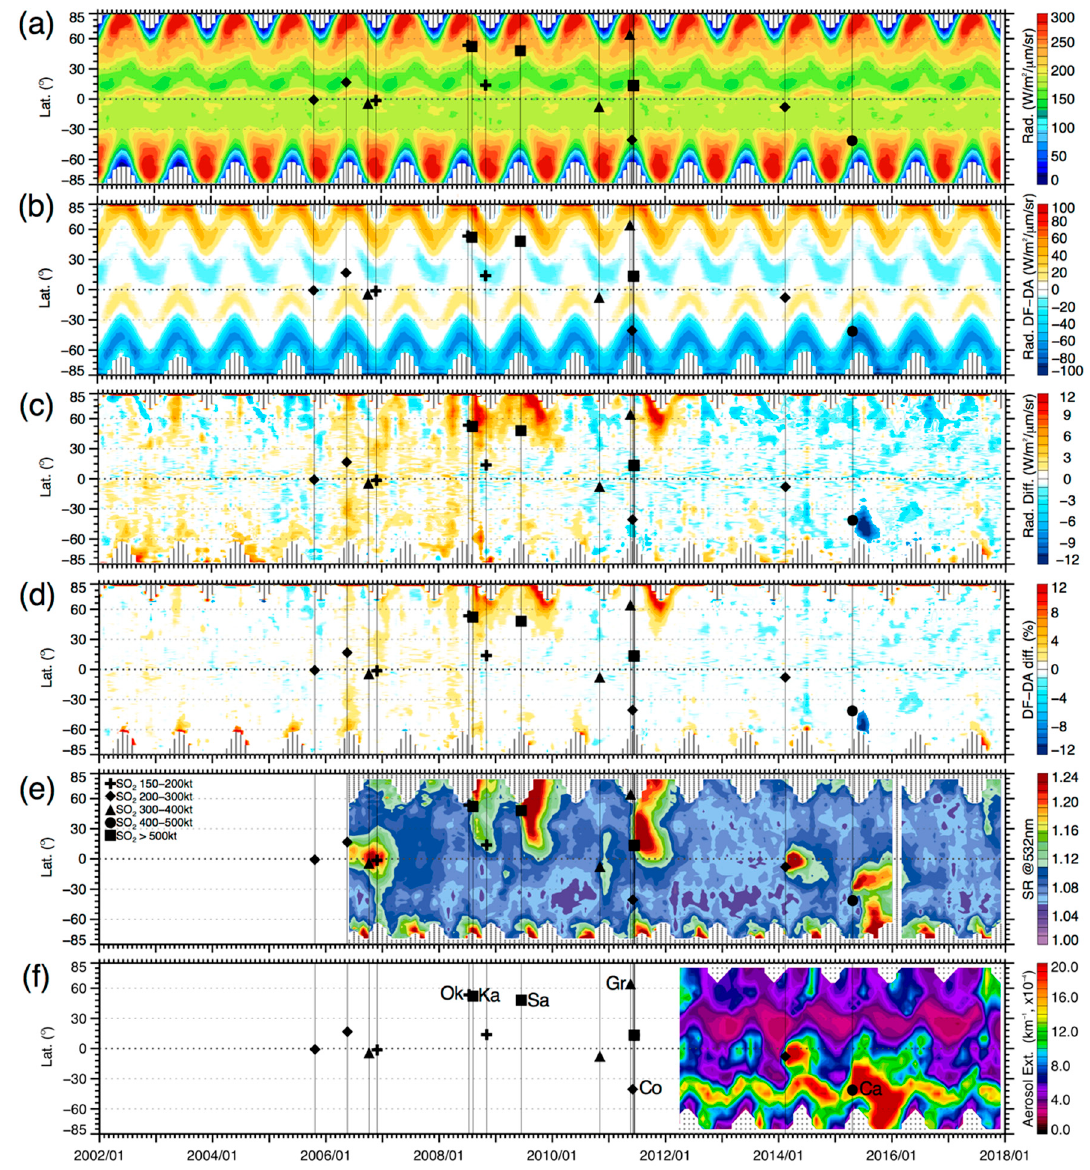
F igure 8. Time series of MISR monthly radiances from the blue band ( a ) DF, ( b ) DF-DA, ( c ) de-seasonalized DF-DA radiance, ( d ) de-seasonalized DF-DA difference in %, ( e ) CALIPSO lidar SR integrated between tropopause (TP) and TP+5km, and ( f ) OMPS-LP v1.5 aerosol extinction between TP and TP+5km. Volcanic eruptions with injection height > 12 km and SO 2 loading > 0.15 Tg are shown with symbols. MISR radiance units are W/m 2 /nm/sr.